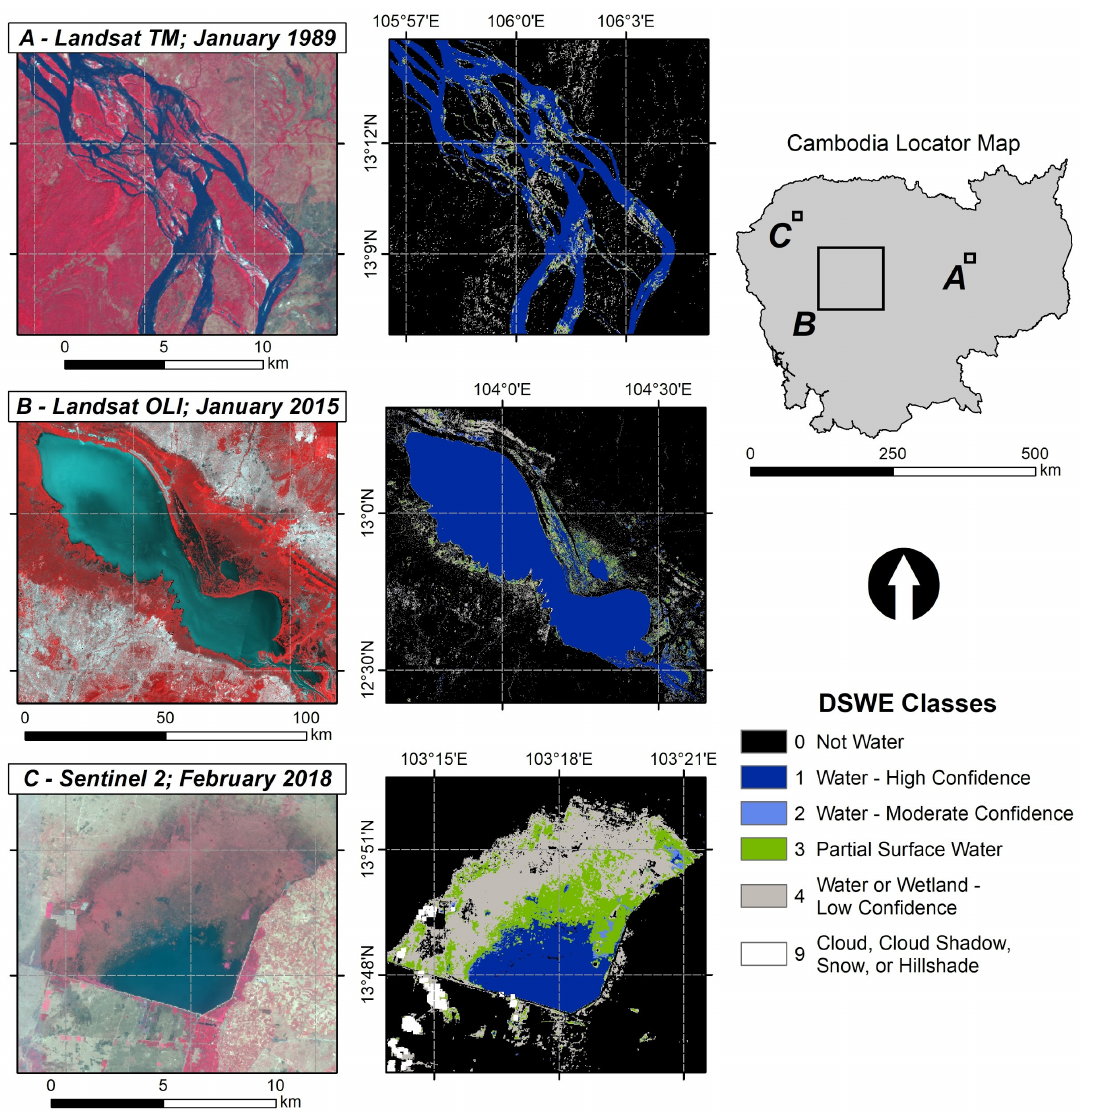
Figure 5. Examples of satellite imagery collected over Cambodia and corresponding DSWE maps. ( Left ) Landsat and Sentinel-2 images are represented as false color composites (NIR-R-G). ( Right ) Corresponding areas are categorized into DSWE classes.